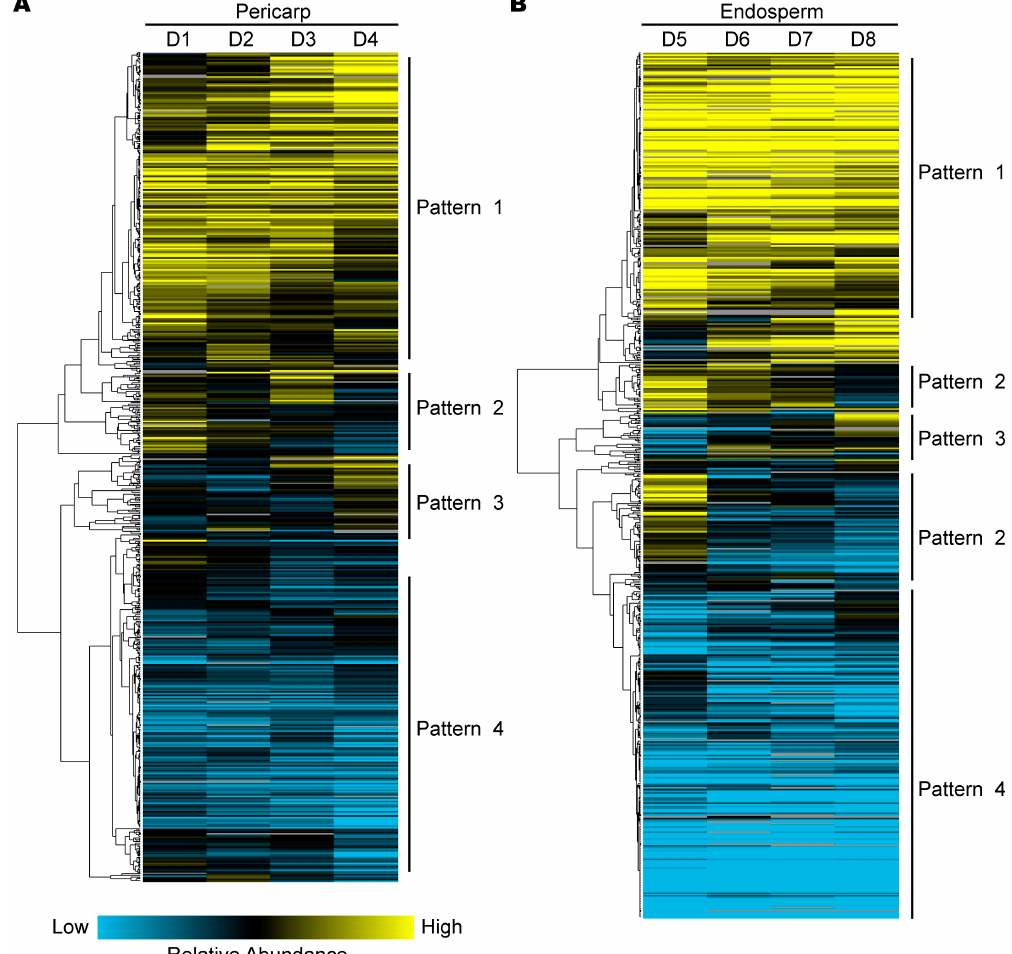
Figure 4. Hierarchical clustering analysis for expression patterns of differentially expressed proteins identified in: pericarp ( A ); and endosperm ( B ) by using Cluster 3.0 software. Pattern 1: up-regulated expression; Pattern 2: up–down-regulated expression; Pattern 3: down–up-regulated expression; Pattern 4: down-regulated expression.